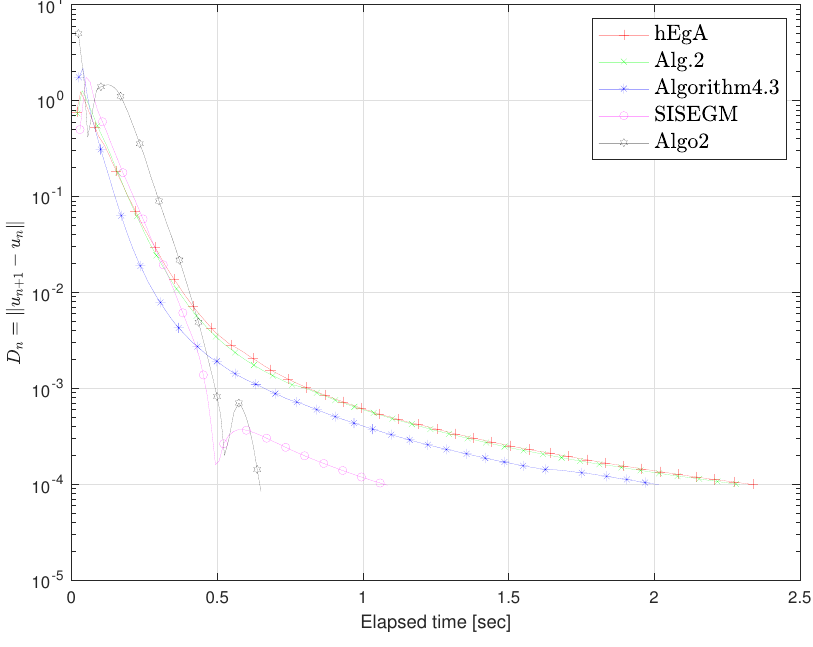
Figure 14. Example 2: Elapsed time 2.33, 2.29, 2.01, 1.08, 0.64 respectively.